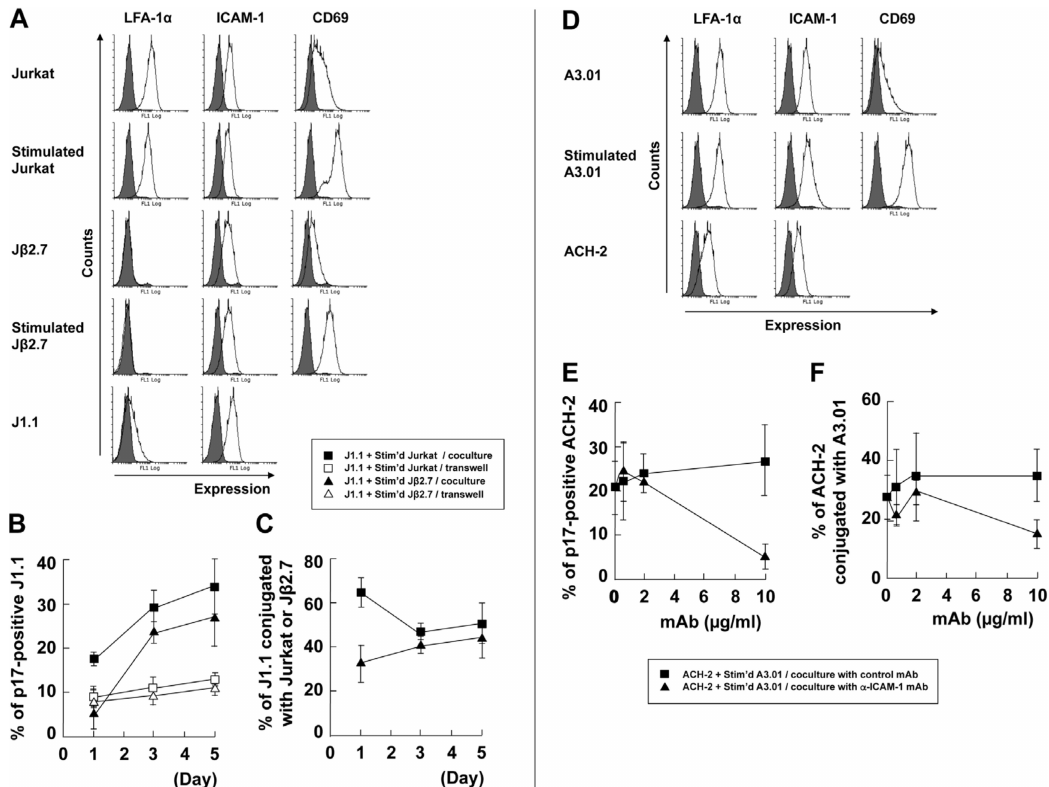
Figure 3. LFA-1–ICAM-1 interaction is responsible for cell conjugation with latently infected cells and reactivation of HIV-1. ( A–C ) Coculture of J1.1 cells with LFA-1 α -deficient Jurkat cells. ( A ) Expression of LFA-1, ICAM-1, and CD69 on the cell surface. The cell surface of Jurkat (stimulated and unstimulated), J β 2.7 (LFA-1 α -deficient Jurkat) (stimulated and unstimulated), and J1.1 cells was immunostained with anti-LFA-1 α , anti-ICAM-1, and anti-CD69 mAbs. Gray-shaded histograms show negative controls.